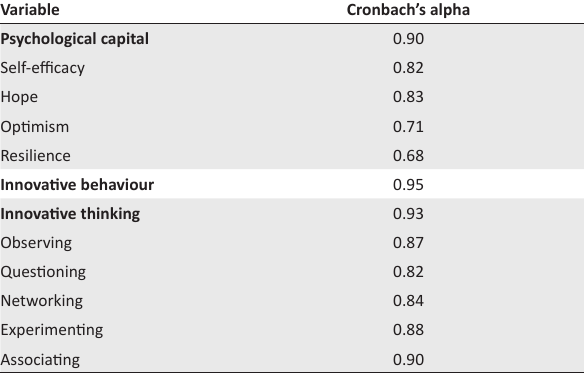
TABLE 3: Reliability of measuring